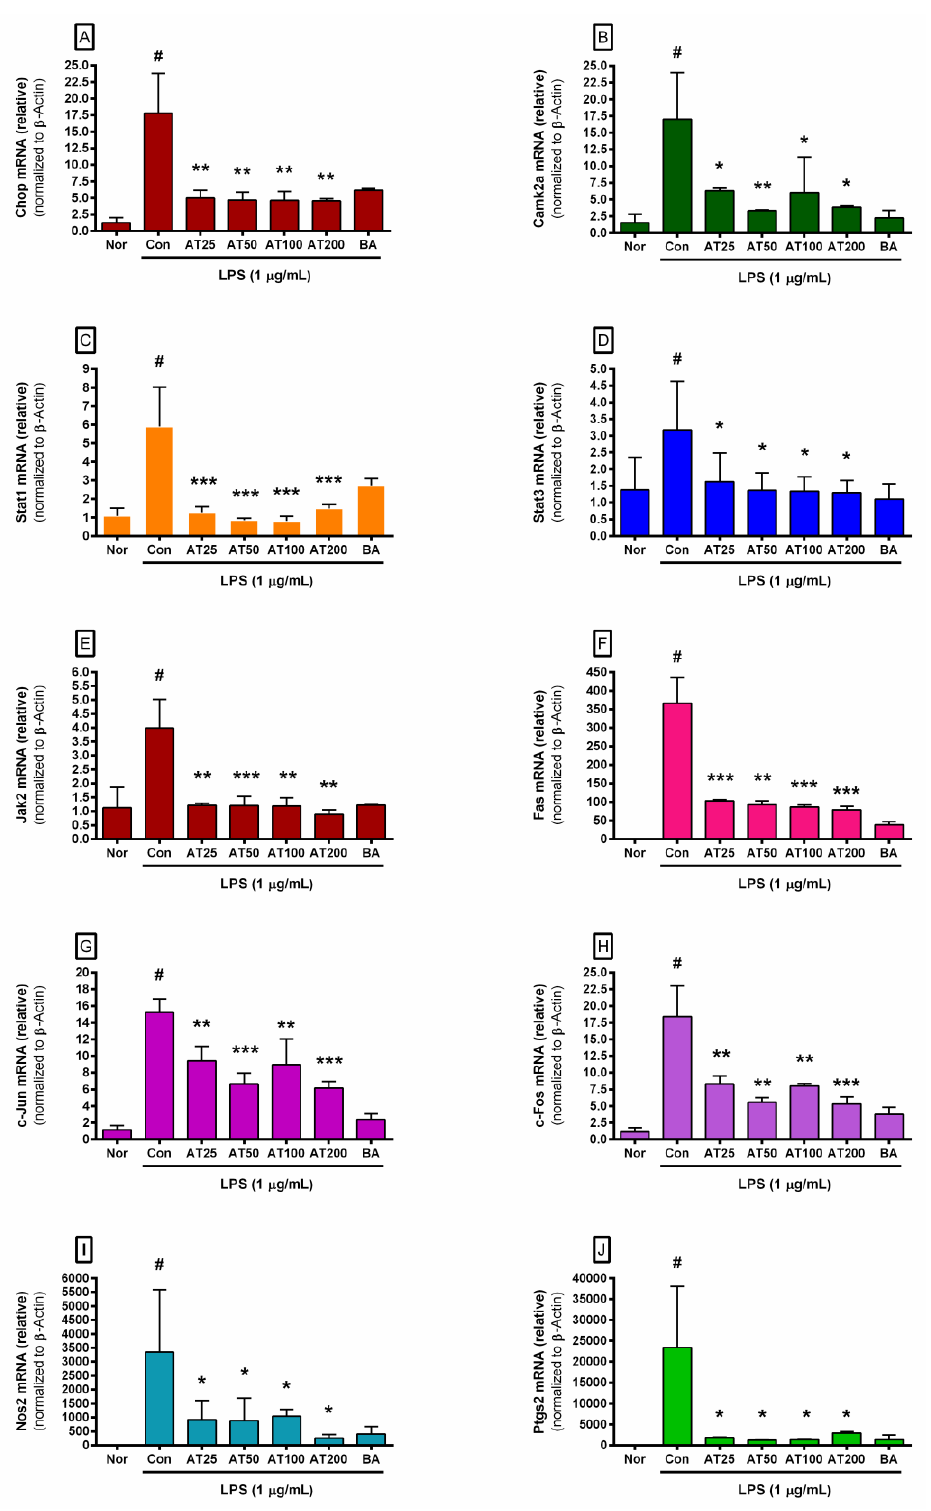
Figure 5. Effects of AT on mRNA expression levels of Chop ( A ), Camk2a ( B ), Stat-1 ( C ), Stat-3 ( D ), c-Jun ( E ), c-Fos ( F ), Jak2 ( G ), Fas ( H ), Nos2 ( I ), and Ptgs2 ( J ) in RAW 264.7 activated by LPS. Values are presented as mean ± SD. Nor, the group treated with cell culture media alone; Con, the group treated with lipopolysaccharide (LPS, 1 µg/mL) alone. AT25 means 25 µg/mL of AT, AT50 means 50 µg/mL of AT, AT100 means 100 µg/mL of AT, and AT200 means 200 µg/mL of AT. BA, baicalein (25 µM). #, p < 0.05 vs. Nor; *, p < 0.05 vs. Con; **, p < 0.01 vs. Con; ***, p < 0.001 vs. Con.